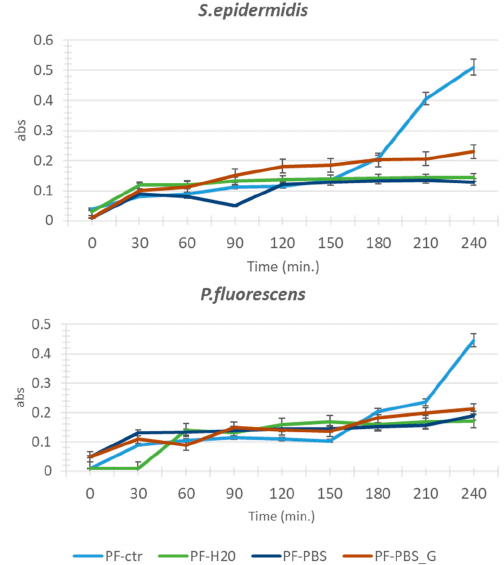
Figure 1. Relationship between time and adhesion of the two strains, to polystyrene micro-titer plates as function of environmental conditions.